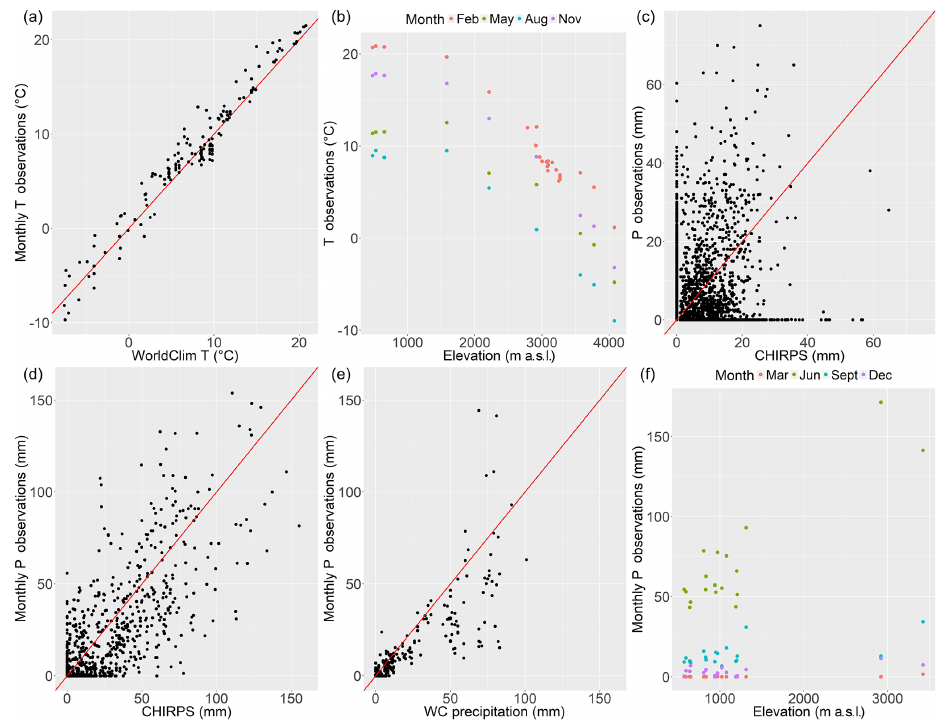
Figure 4. (a) WC values versus monthly aggregated (averaged) temperature values. (b) Elevation of gauges versus average temperature in 4 months. (c) CHIRPS versus precipitation. Daily values for all stations used. (d) Monthly aggregated (sum) CHIRPS versus monthly aggregated (sum) precipitation values. (e) WC values versus monthly aggregated (sum) precipitation values. (f) Elevation of gauges versus average precipitation for 4 months. The red lines correspond to the 1 : 1 line.